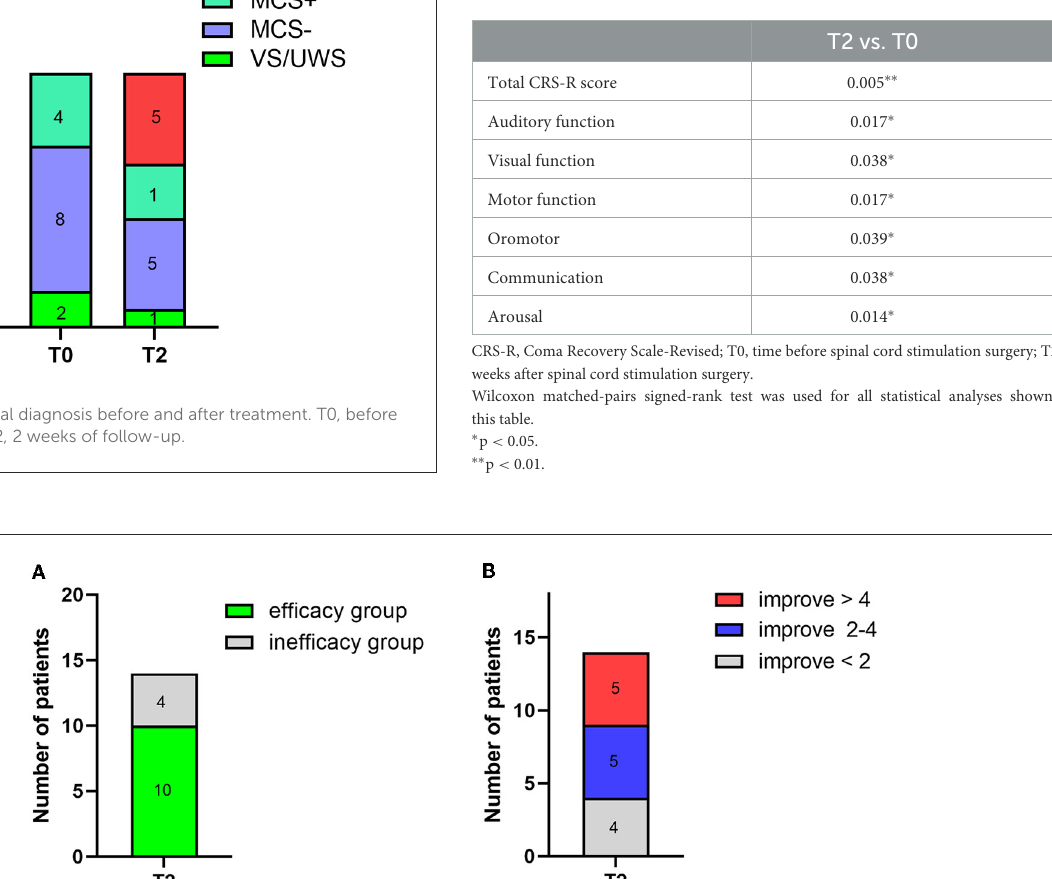
TABLE 4 Statistical analysis ( p -value) of behavioral assessment by the CRS-R test.